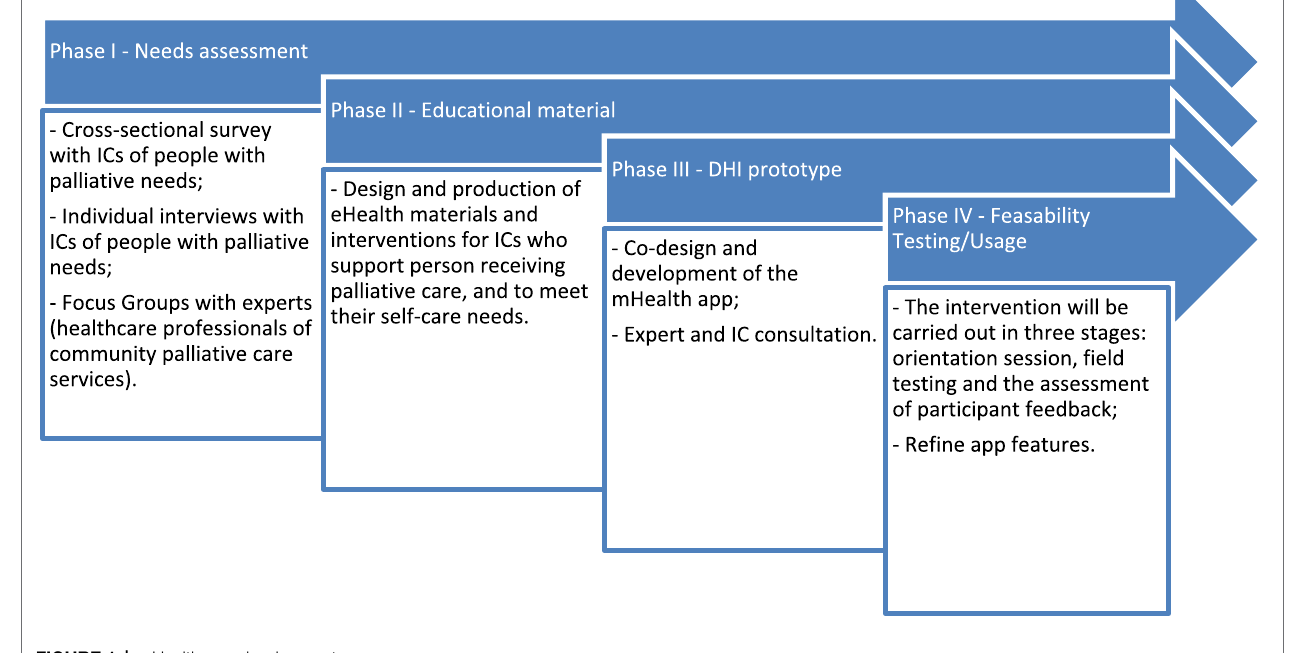
FIGURE 1 | mHealth app development